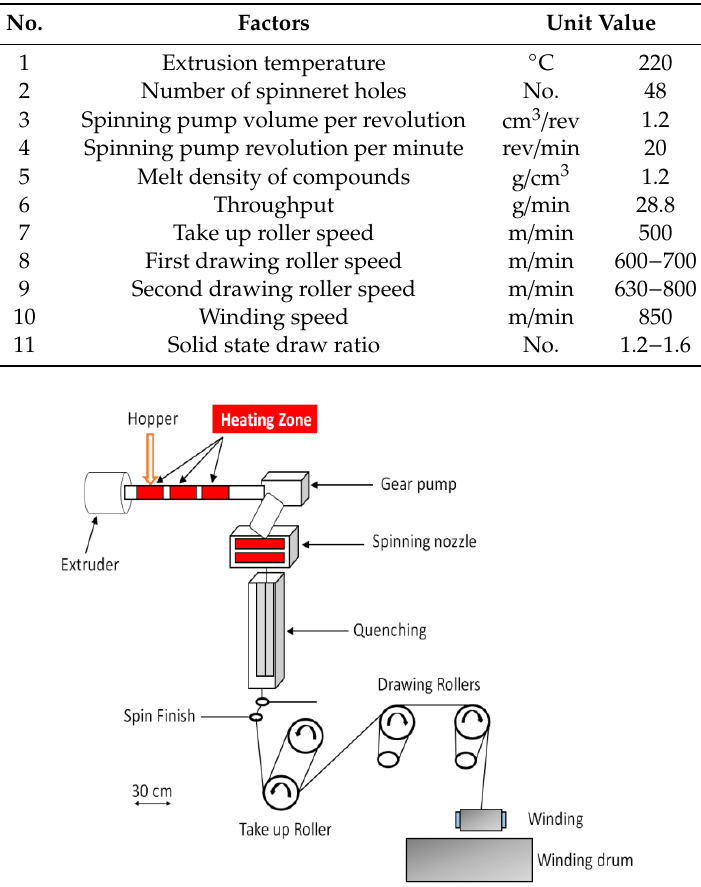
Table 2. Spinning parameters to produce multifilament fibers.